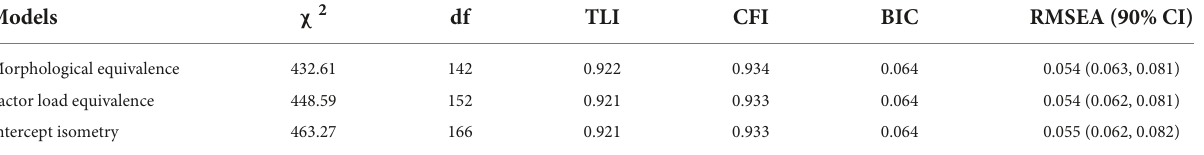
TABLE 6 Cross-gender equivalence test in Chinese version of SEIS.